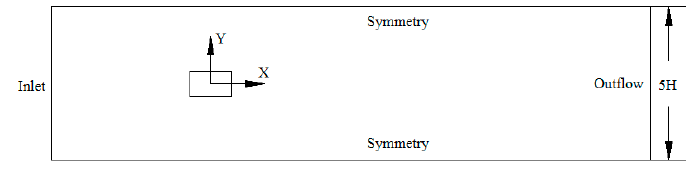
Figure 2. Simulation flow domain: ( a ) Top view; ( b ) Front view.